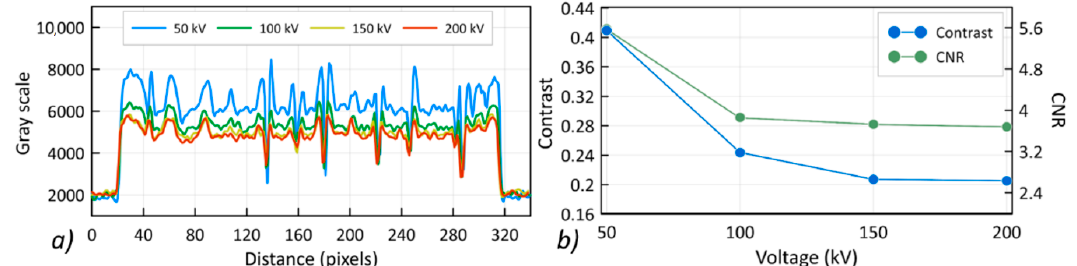
Figure 7. The influence of the X-ray tube voltage on the contrast recorded for the PP composite, ( a ) change of contrast along the A-B line, ( b ) change of contrast and contrast-to-noise ratio (CNR).